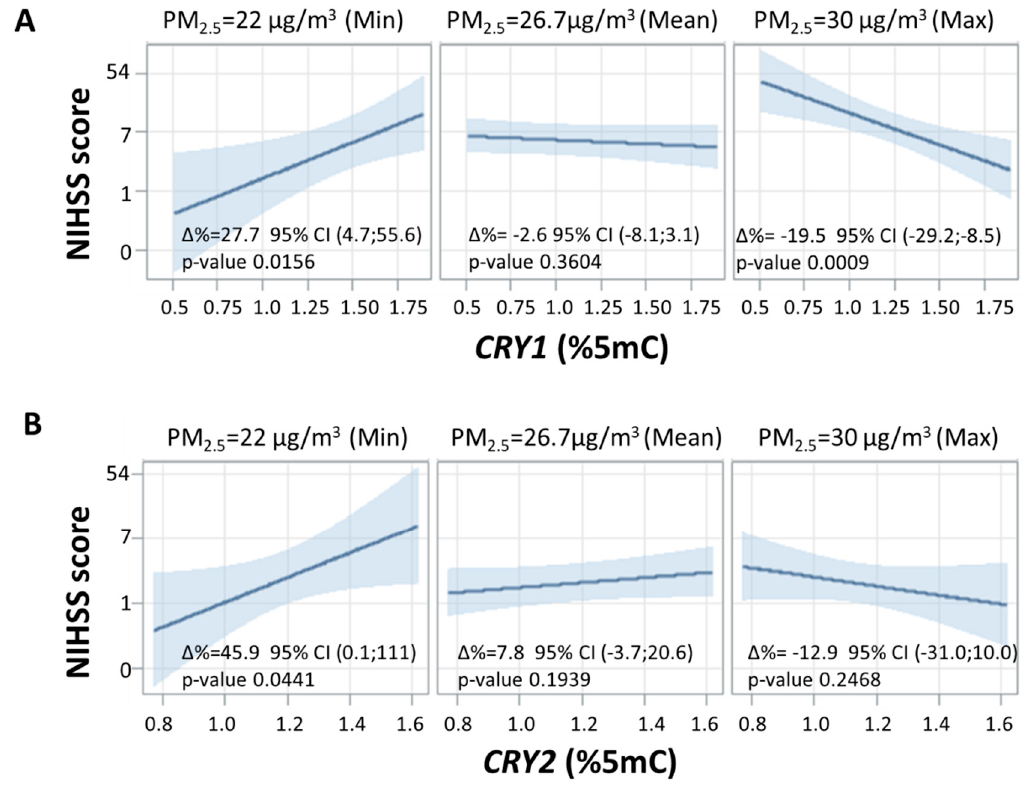
Figure 2. Interaction e ff ect of PM 2.5 annual average and clock gene methylation on NIHSS score. Strength of association between clock gene methylation and NIHSS score on natural logarithmic scale at three selected levels of annual average PM 2.5 (min, mean, and max). Panels ( A , B ) represent CRY1 and CRY2 , respectively. For all panels, ∆ % is equal to (exp( β / 10)–1) × 100 and represents the percentage increase in NIHSS score for 0.15mC% increase in CRY1 / CRY2 methylation at each concentration of annual average PM 2.5 . Linear regression models were adjusted for age, sex, smoking habits, diabetes, hypertension, plate, and warm/cold months (months with heaters switched on/off).